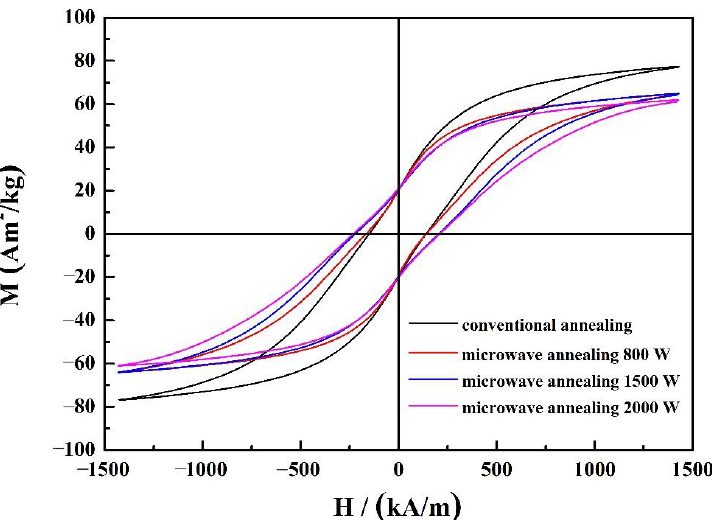
Figure 5. Hysteresis loop curves of the annealed (Nd 0.525 Pr 0.175 Ce 0.3 ) 9 Fe 64.5 Co 3 Cu 0.5 Ti 1 B 22 ribbons under different conditions. Table 2. The magnetic properties of the annealed (Nd 0 . 525 Pr 0 . 175 Ce 0 . 3 ) 9 Fe 64 . 5 Co 3 Cu 0 . 5 Ti 1 B 22 ribbons under different annealing conditions.